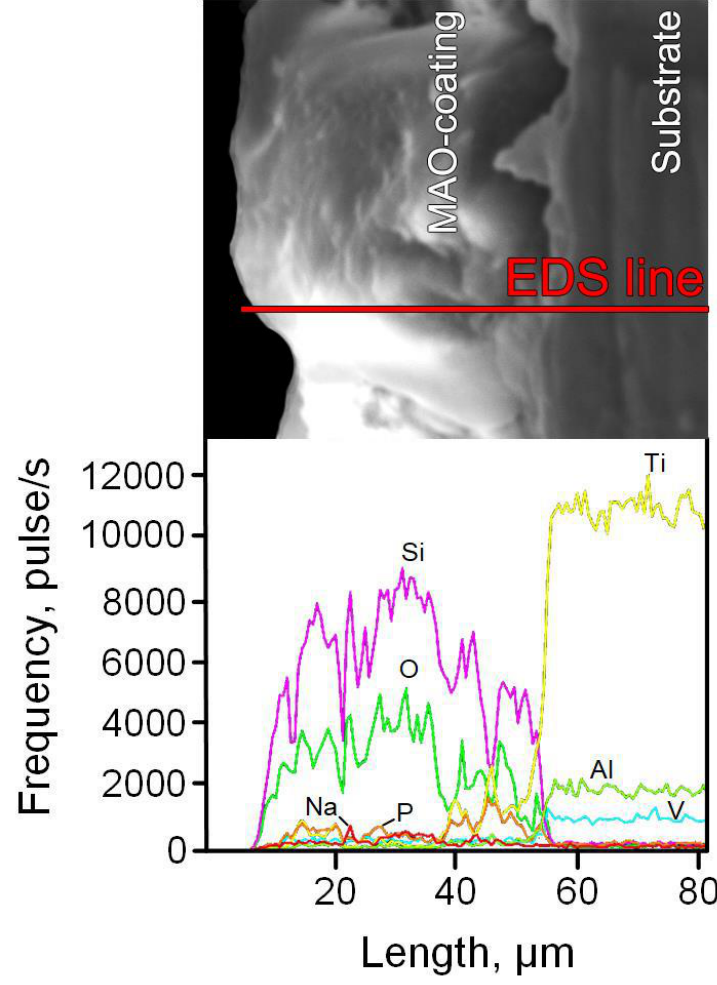
Figure 4. The cross-sectional microstructure of MAO coating (Ti-MAO-20-30_bT), and the element distribution along the marked line.